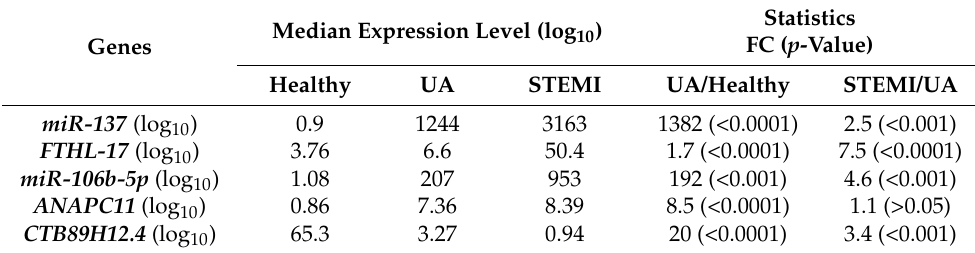
Statistics FC ( p -Value)